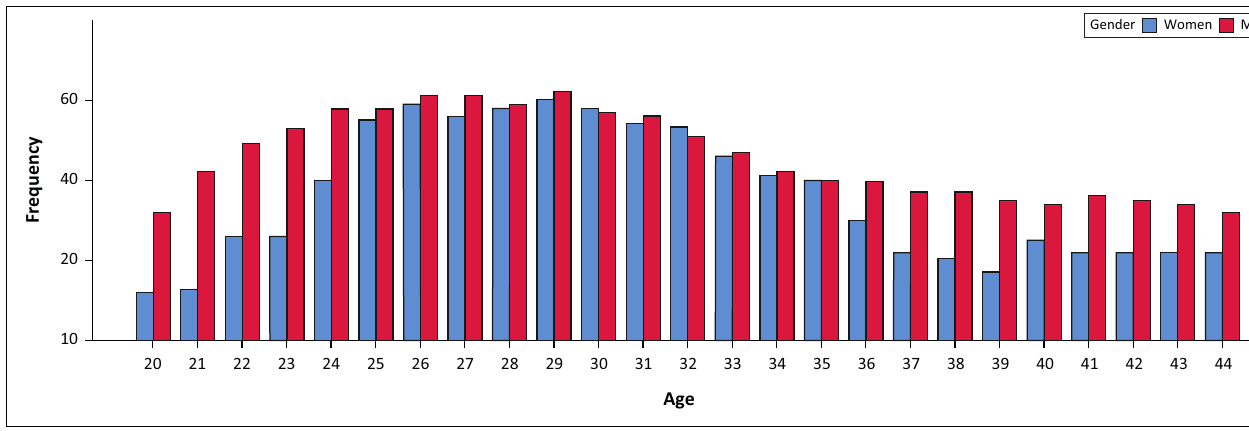
FIGURE 1: Gender and age distribution of